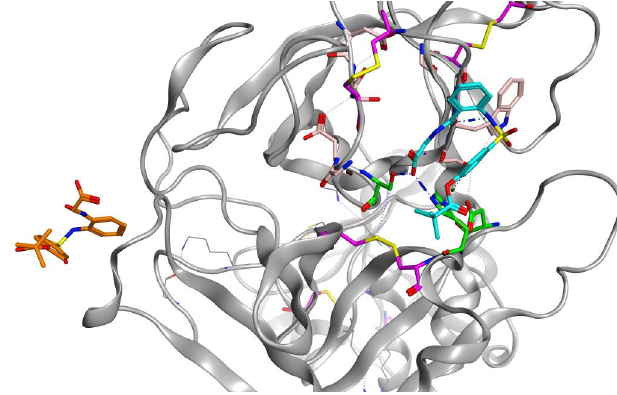
Figure 11. ( A ) 2D Ligand interactions and ( B ) 3D visualization of gabexate.